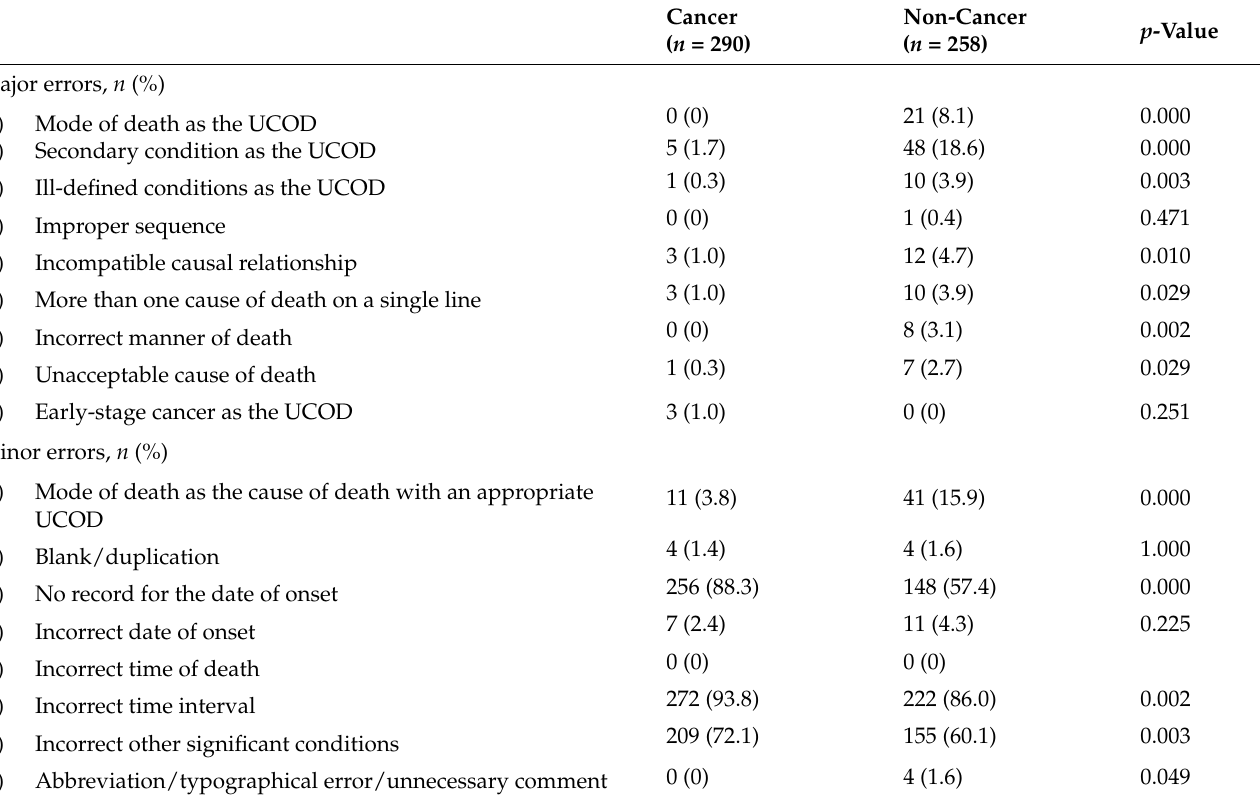
Table 5. Errors on death certificates according to a cancer